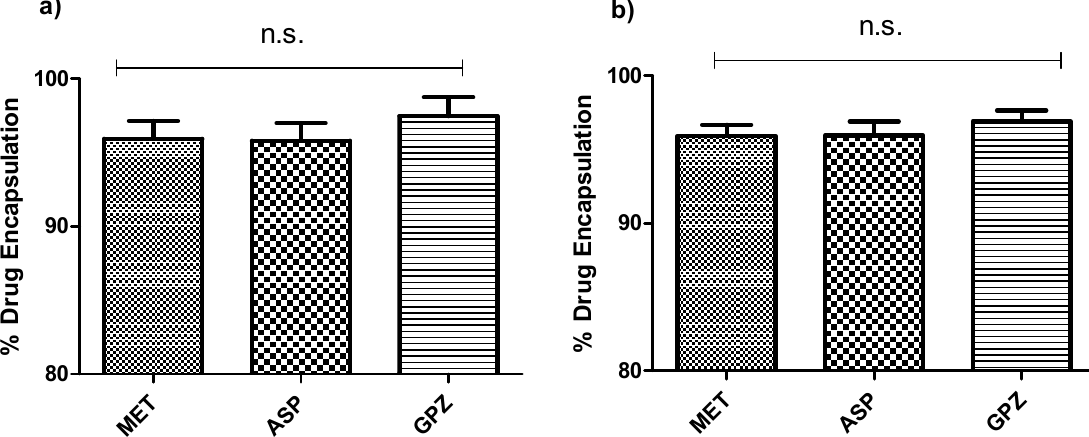
Figure 4. Three model drugs—metformin (MET), Aspirin (ASP), and Glipizide (GPZ)—and their percent drug encapsulation determined spectrophotometrically ( n = 4, ± SD). (n.s. = not significant). ( a ) Alginate capsules without MMT and ( b ) alginate capsules enhanced with MMT. The SD ± % represents the content uniformity of the encapsulated drug in the